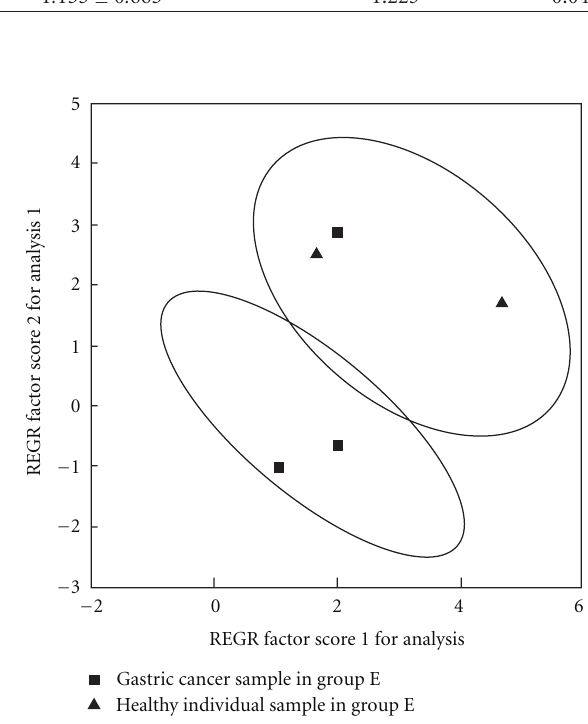
Figure 6: PCA of urine-free amino acids in group E (test result of diagnosis model for gastric